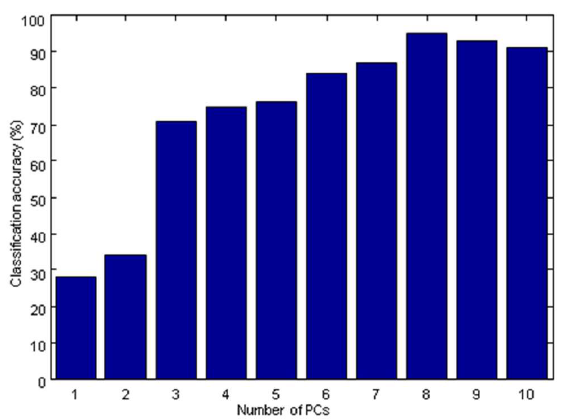
Figure 5. Classification accuracy of the partial least squares-discriminant analysis (PLS-DA) model according to different number of PCs.